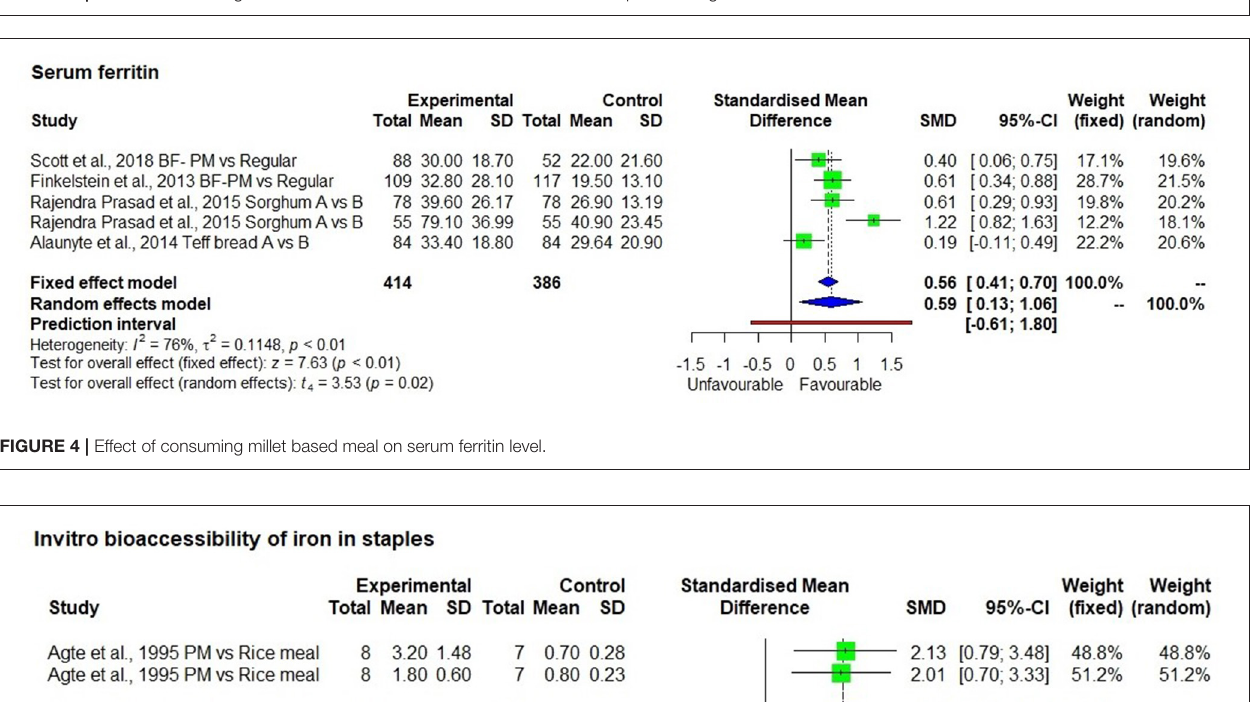
FIGURE 3 | Effect of consuming millet based meal on bioavailable iron content compared to regular meal.